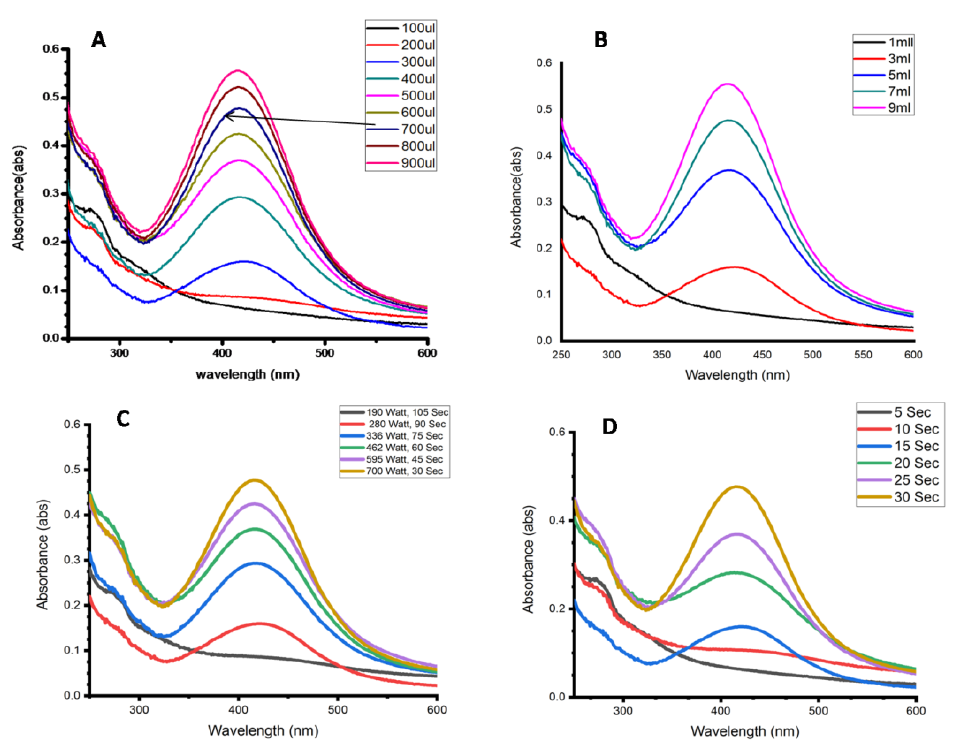
Figure 3. ( A ) Effect of salt (AgNO 3 ); ( B ) Effect of xanthan gum (XG); ( C ) Effect of power; and ( D ) Effect of irradiation duration on AgNPs.